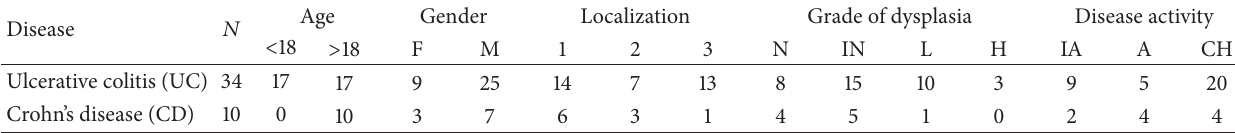
Table 1: Demographic and histological characteristics of the study group. Disease